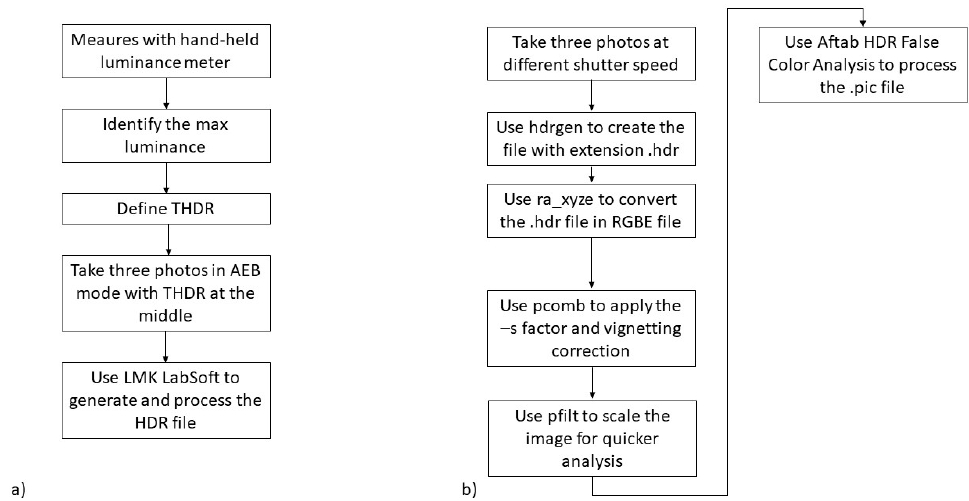
Figure 4. Flowchart used to create false-colour luminance map: ( a ) professional system; ( b ) low-cost system.